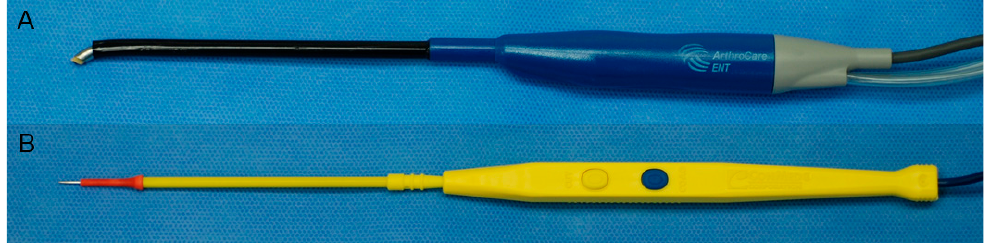
Figure 2. Surgical instruments used for coblation and electrocautery tonsillectomy, respectively. ( A ) Coblation hand-piece; ( B ) monopolar electrocautery hand-piece.